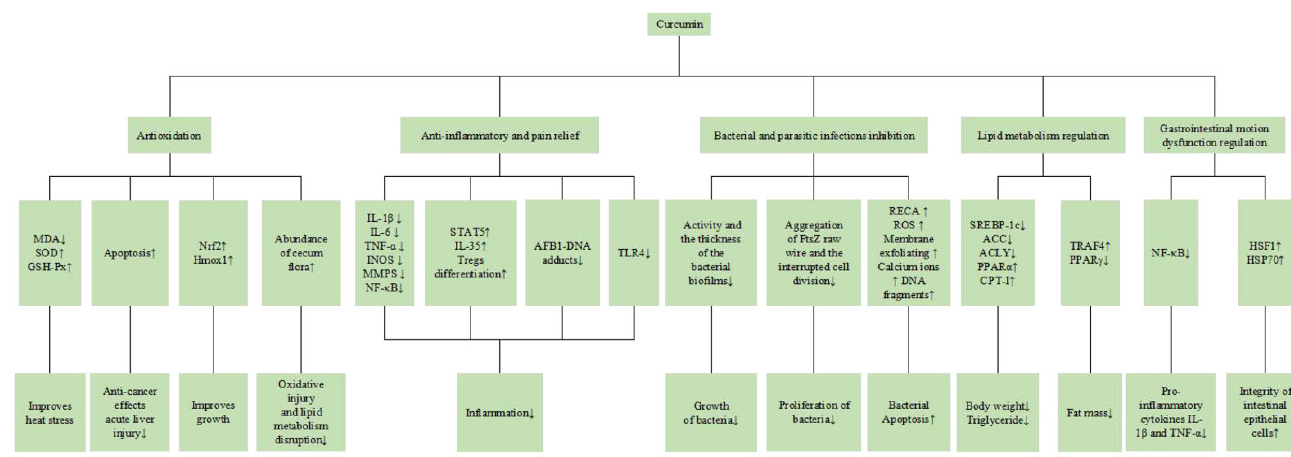
Figure 2. The biological functions of CUR.